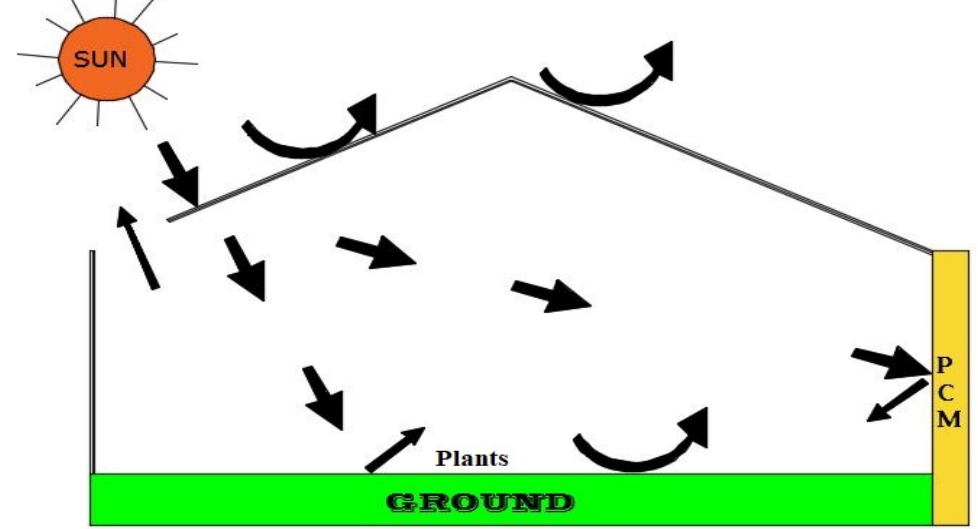
Figure 4. Greenhouse dryer with a PCM on the north wall [19].